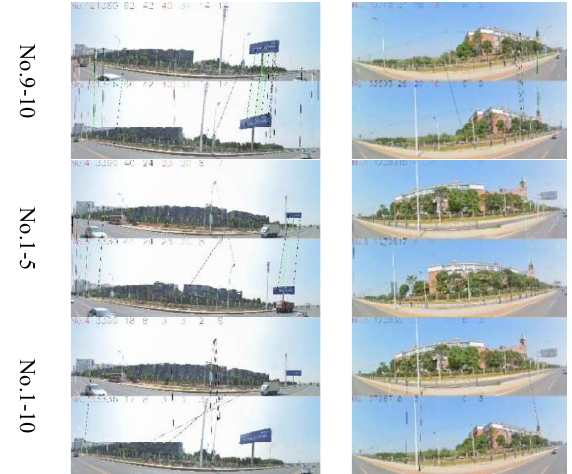
Figure 6 . Feature points matching of 3 pairs in dataset I Then, we extract and match the feature points of 10 panoramic images in dataset I. In addition, the discontinuous panoramic filtering are insufficient, the feature points are directly used.